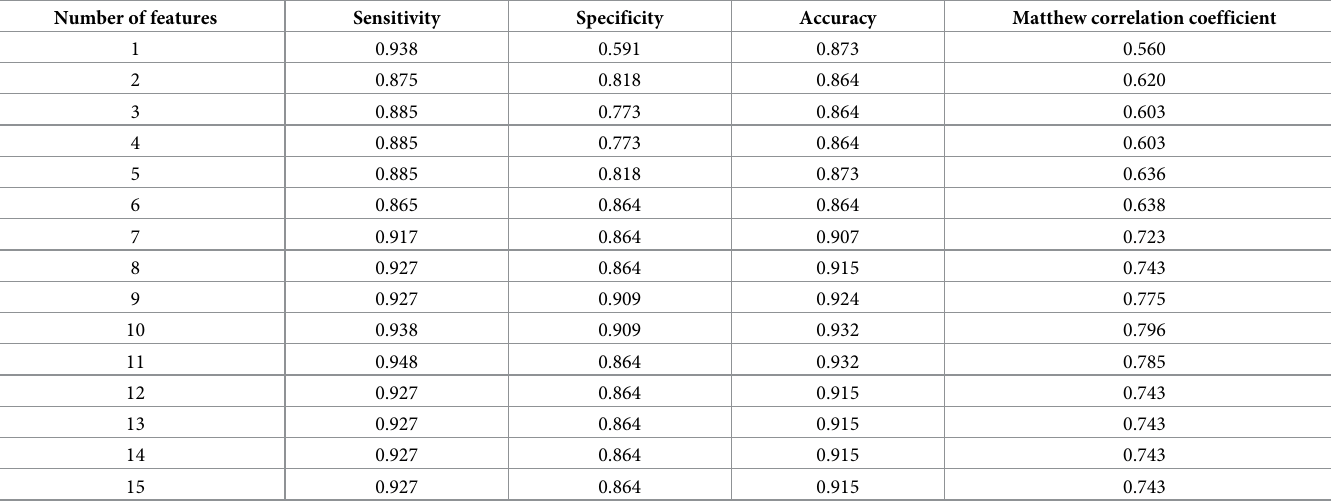
Table 2. IFS performance with SVM and different top features.